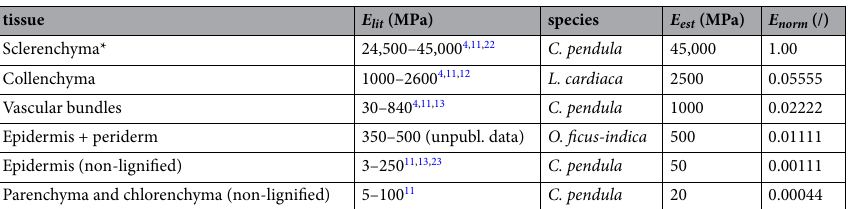
Table 2. Elastic moduli of individual plant tissues. Literature values ( E lit ) and estimated values ( E est ) for the species Carex pendula , Leonurus cardiaca and Opuntia ficus-indica are provided. *Since the elastic modulus of the sclerenchyma had the highest value, it was used as the reference tissue for the calculation of the normalised elastic moduli ( E norm ) used in the mathematical